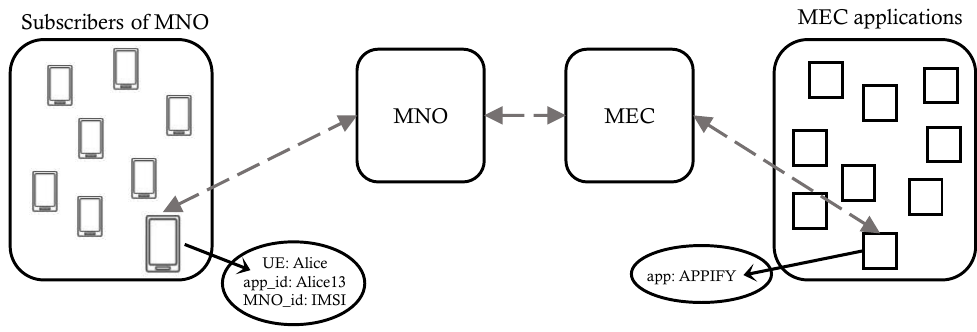
Figure 2. Elements of the system